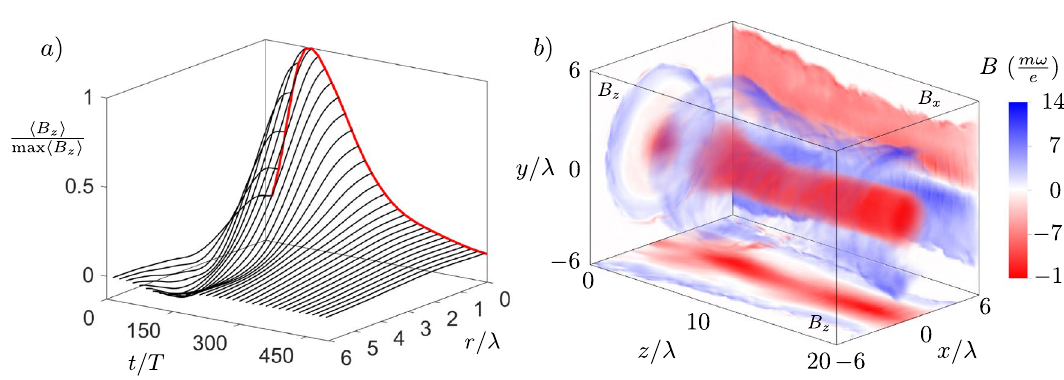
200, n 10 . ( a ) Time evolution of e / n c = =